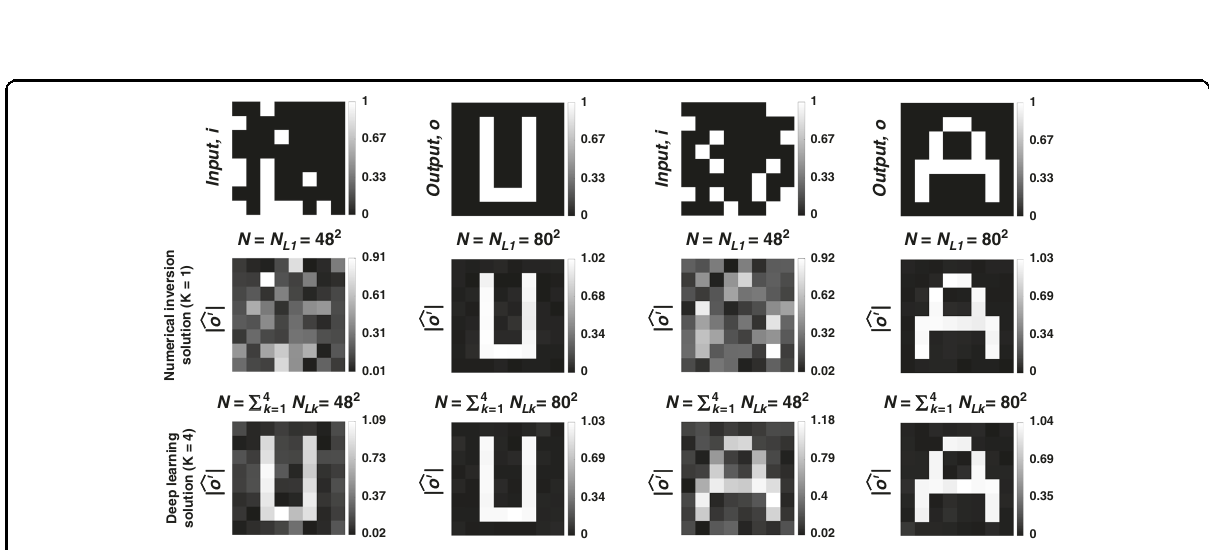
Fig. 12 Sample input – output images for the ground truth transformation presented in Fig. 10b and the optical outputs by the diffractive designs with N = 48 2 and N = 80 2 . The magnitude and phase of the normalized output fi elds and the differences of these quantities with respect to the ground truth are